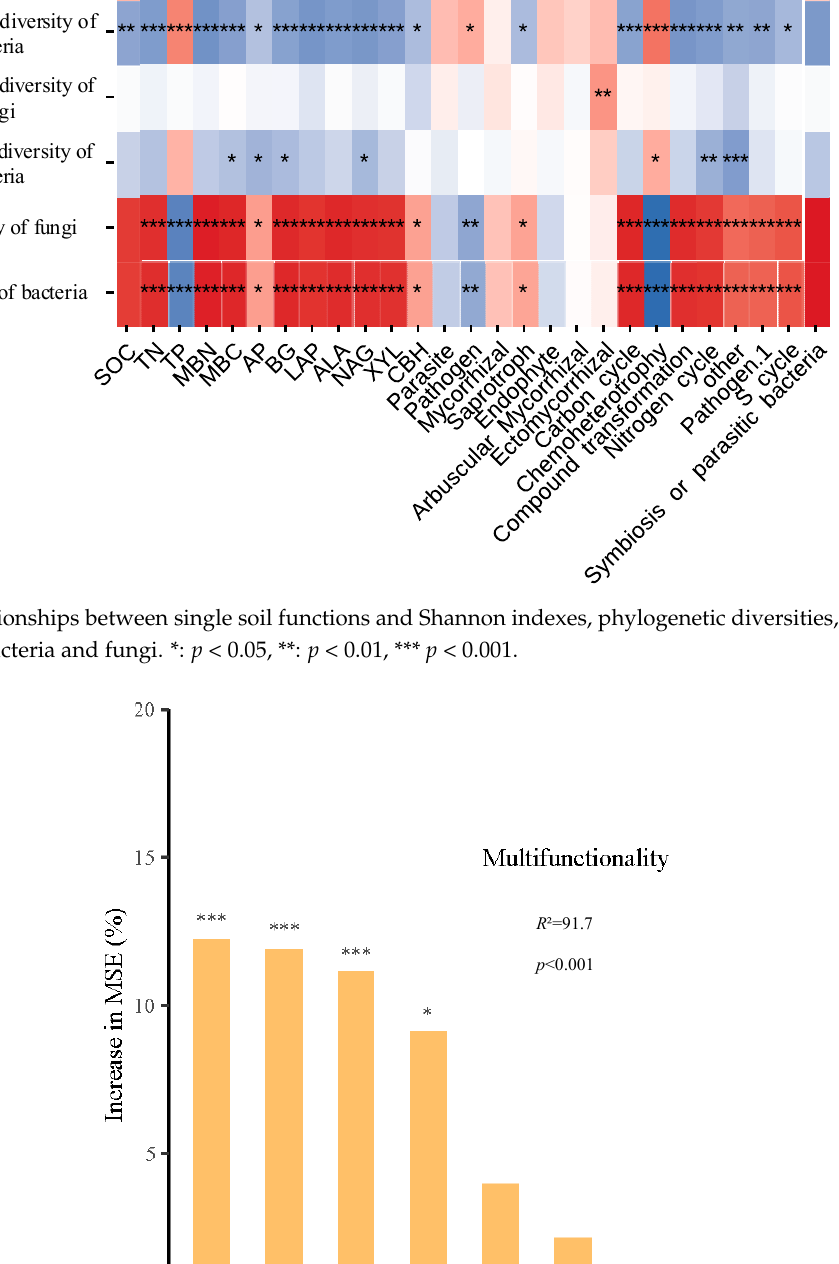
Figure 4. The relationships between soil EMF and Shannon indexes, phylogenetic diversities, and communities composi- tions ( β diversity) of bacteria and fungi.